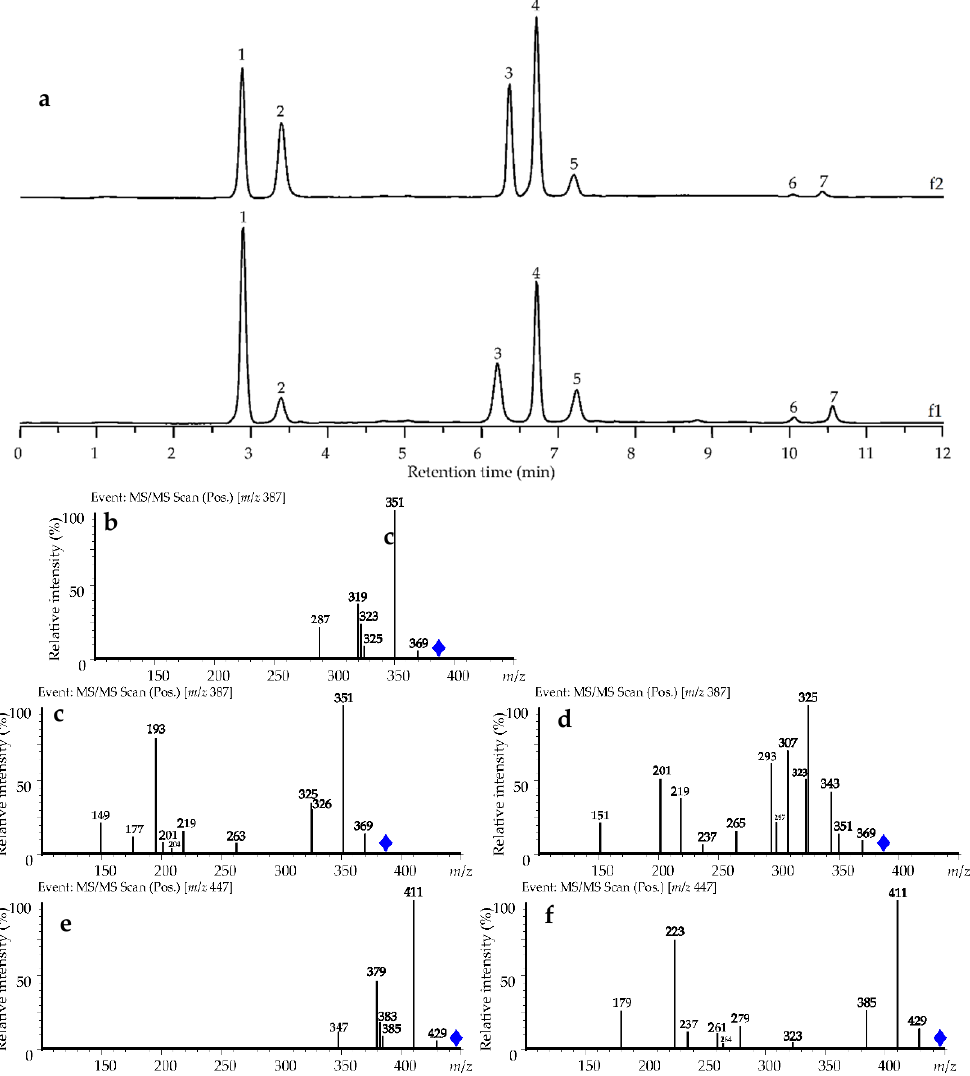
Figure 5. HPLC chromatogram of alkaline destruction products of DEAE–1% NaOH-f1 (f1) and DEAE–1% NaOH-f2 (f2) polymers ( a) degradation products labeled 1–7 as described in Table 7 and ESI–MS/MS spectra (positive ionization) of degradation products 3 ( b ), 4 ( c ), 5 ( d ), 6 ( e ), and 7 ( f ). Table 7. Characterization and content of degradation products released after alkaline destruction of